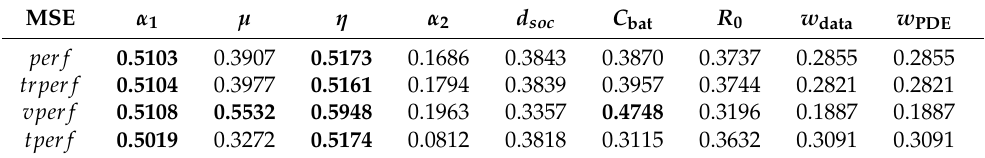
Table 6. Correlation coefficients of performance with nine main fractional-order parameters.